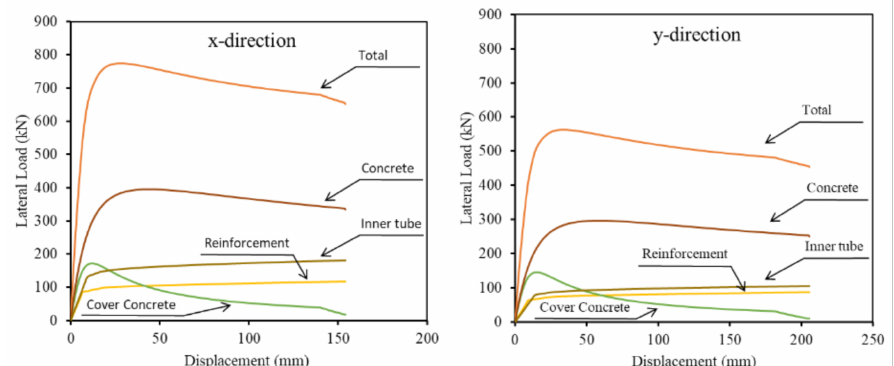
Figure 15. Lateral load-displacement of each member (rectangular cross-section).